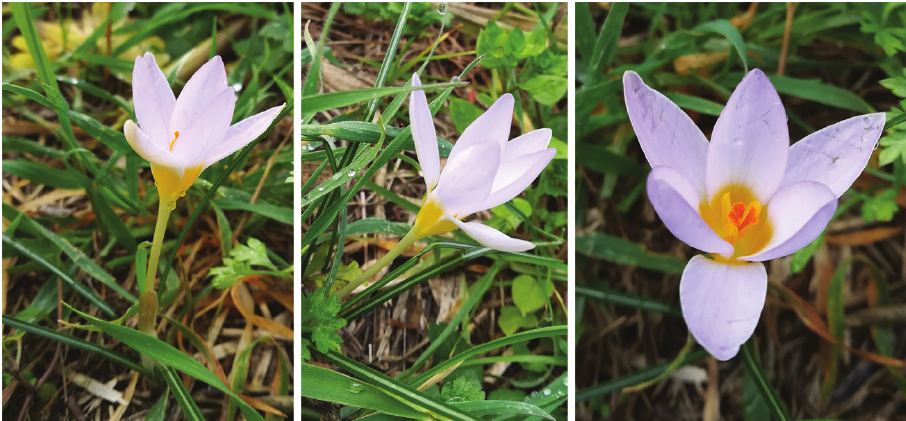
Figure 1. Crocus biflorus var. estriatus from the epitype locality in Empoli, Firenze (photos by L.